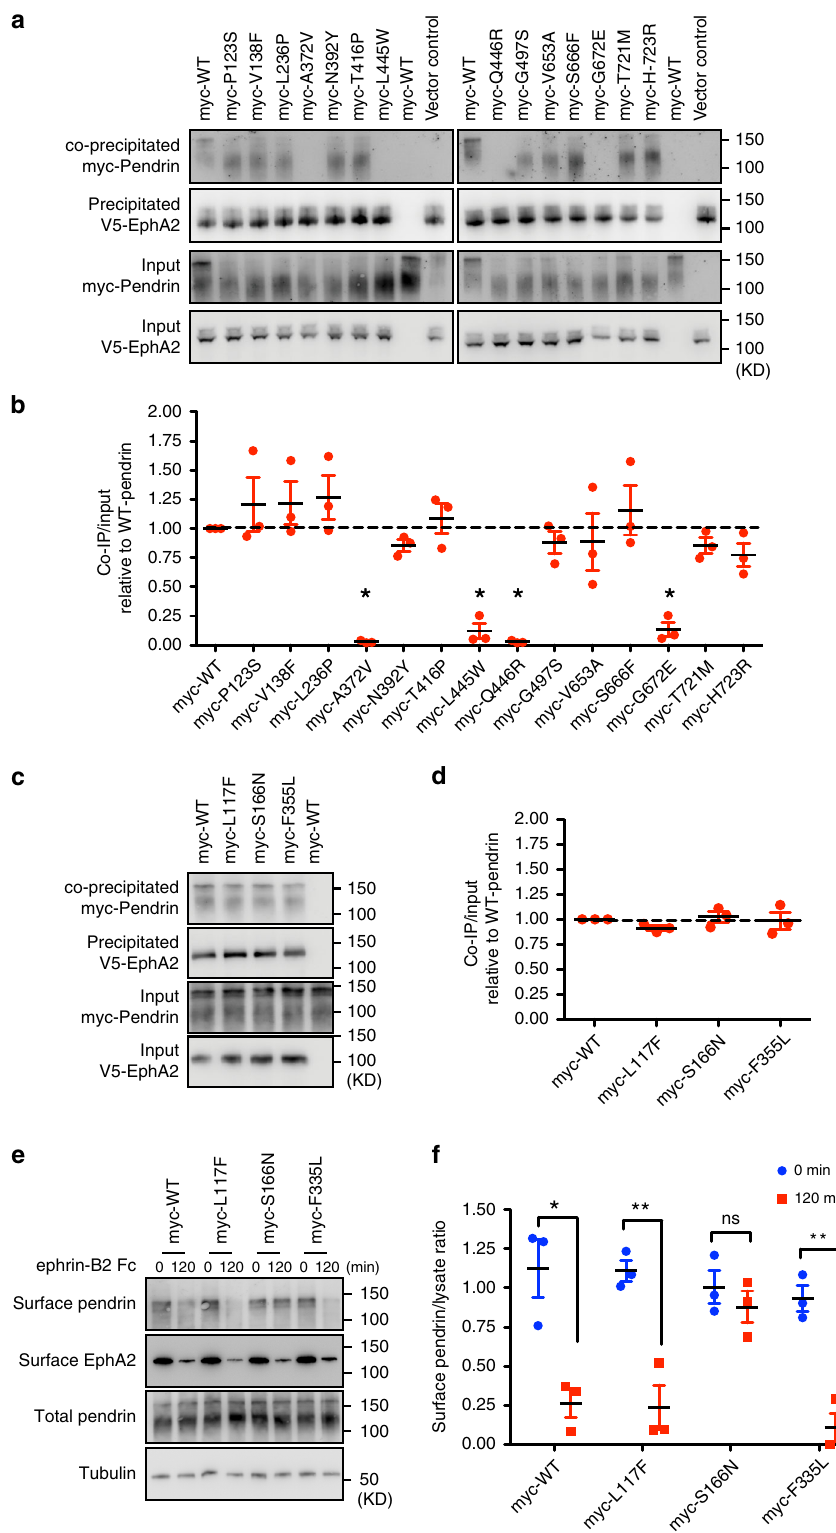
Fig. 5 Some pathogenic variants of pendrin are not affected by EphA2/ephrin-B2 regulation. a , b Immunoprecipitation of EphA2 with mutated pendrin. myc-pendrin A372V, L445W, Q446R, G672E were not co-immunoprecipitated with EphA2. Densitometric quanti fi cations are shown ( b ). Mean±SEM; one- way ANOVA with Bonferroni post hoc analyses; * p <0.05; ( n = 3). c , d Immunoprecipitation of EphA2 with mutated pendrin. Immunocomplex of myc-pendrin L117F, S166N and F355L was not affected. Densitometric quanti fi cations are shown ( d ). Mean±SEM; ( n = 3). e , f Internalization of EphA2 and mutated pendrin triggered by ephrin-B2 stimulation. Pendrin S166N was not internalized after ephrin-B2 stimulation while EphA2 and other mutated pendrins were not affected. f Relative amount of cell surface pendrin is shown. Mean±SEM; one-way ANOVA; ** p <0.01; * p <0.05; ( n = 3). Source data are provided as a Source Data fi